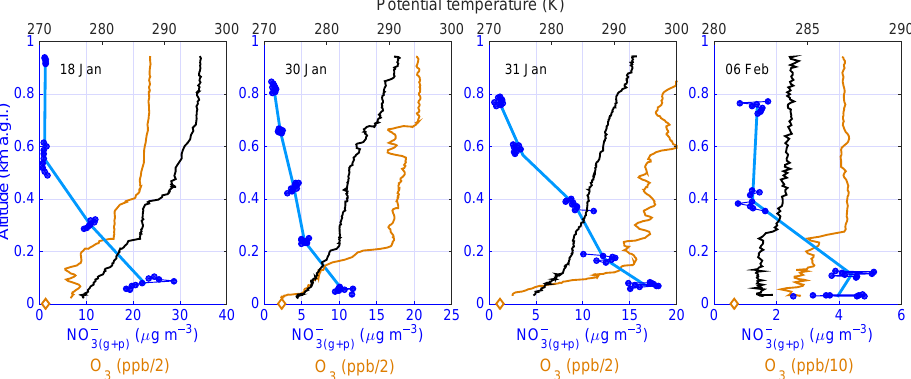
Figure 5. Vertical profiles of NO − (µgm − 3 ) in PM 2 . 5 between 08:00 and 09:00LT over the city of Bakersfield on four flights when 3 ( g + p ) visibility and air traffic permitted a missed approach. Altitude data are in units kma.g.l. The O 3 (orange) and potential temperature (black) are also shown. The orange diamonds represent the mean O 3 measured at the surface (08:00–09:00LT).